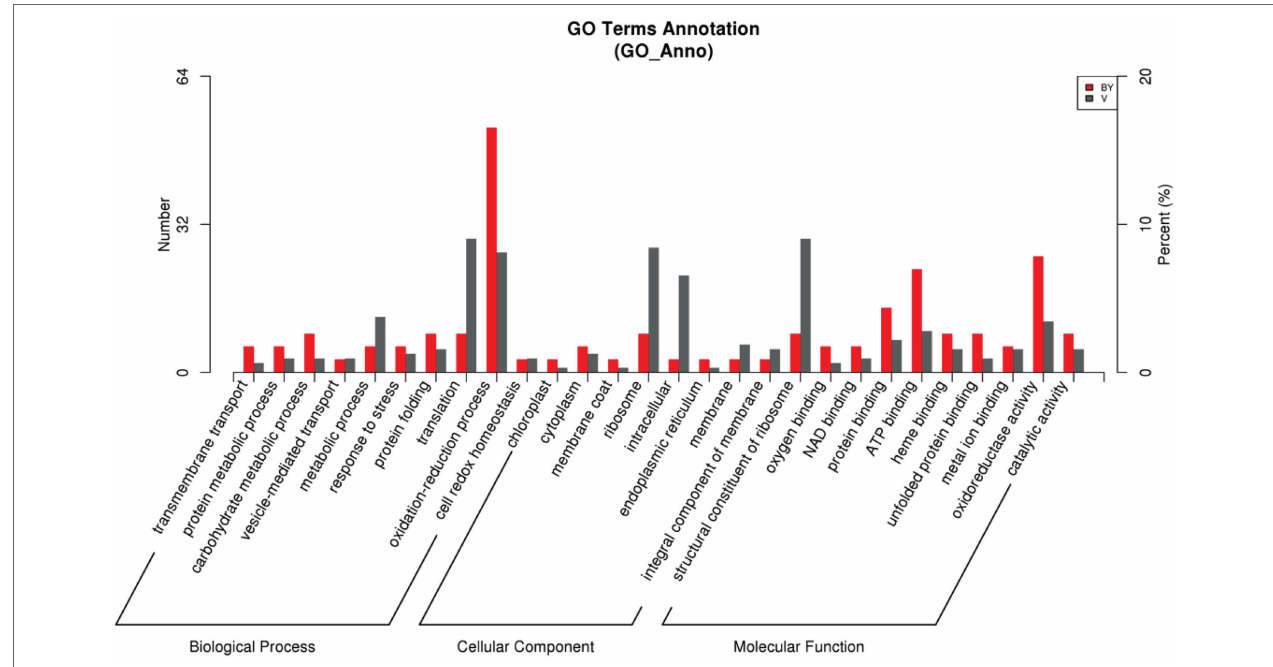
FIGURE 3 | GO function classification of the DEPs.